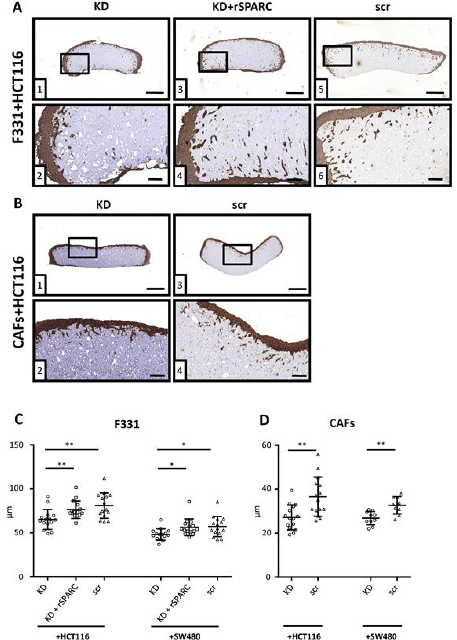
Figure 6. 3D co-culture tissue reconstructs F331 fibroblasts with either SPARC KD, KD + rSPARC or scr control were suspended into a 3D matrix consisting of methylcellulose + collagen type I and allowed to grow and structure their 3D matrix for 4 days. Cancer cells were seeded onto these reconstructs, incubated for an additional 6 days and IHC stained with a cytokeratin antibody. Typical sections of either F331 ( A ) or CAFs ( B ) co-cultured with HCT116 cells used for quantification. Overview of sections can be viewed in corresponding upper panels (size bar = 500 µ m) and zoomed images in lower panels (size bar = 100 µ m), respectively. For each reconstruct, 5 sections separated by 100 µ m were analyzed. Results are shown as average invasion depth per section ( n = 15) for 3 independent experiments using 2 di ff erent siRNAs for both HCT116 and SW480 ( C ). In addition, reconstructs with CAFs co-cultured with either HCT116 or SW480 ( D ) were evaluated as well (15 sections, 3 independent experiments for HCT116 and 10 sections, 2 independent experiments, for SW480; 2 di ff erent siRNAs for both cell lines). Statistical analysis to evaluate di ff erences between 3 groups were performed by using the Kruskal Wallis test followed by Dunn’s multiple comparisons test, and the Mann Whitney test for 2